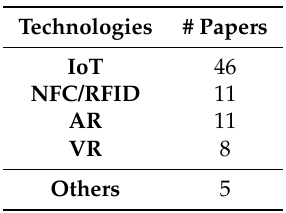
Table 2. Number of papers dealing with certain technologies.